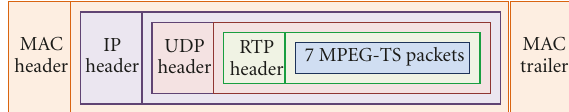
Figure 2: The video data is nested in a structure of packets, each packet and corresponding header results from a di ff erent layer in the protocol